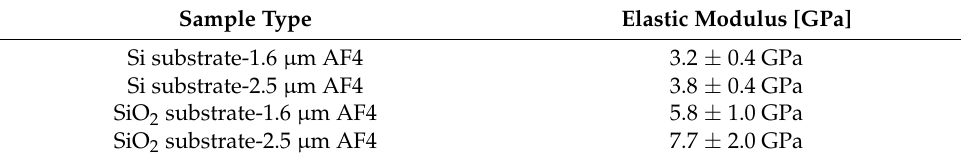
Table 2. Nanoindentation elastic modulus results for the AF4 coatings.